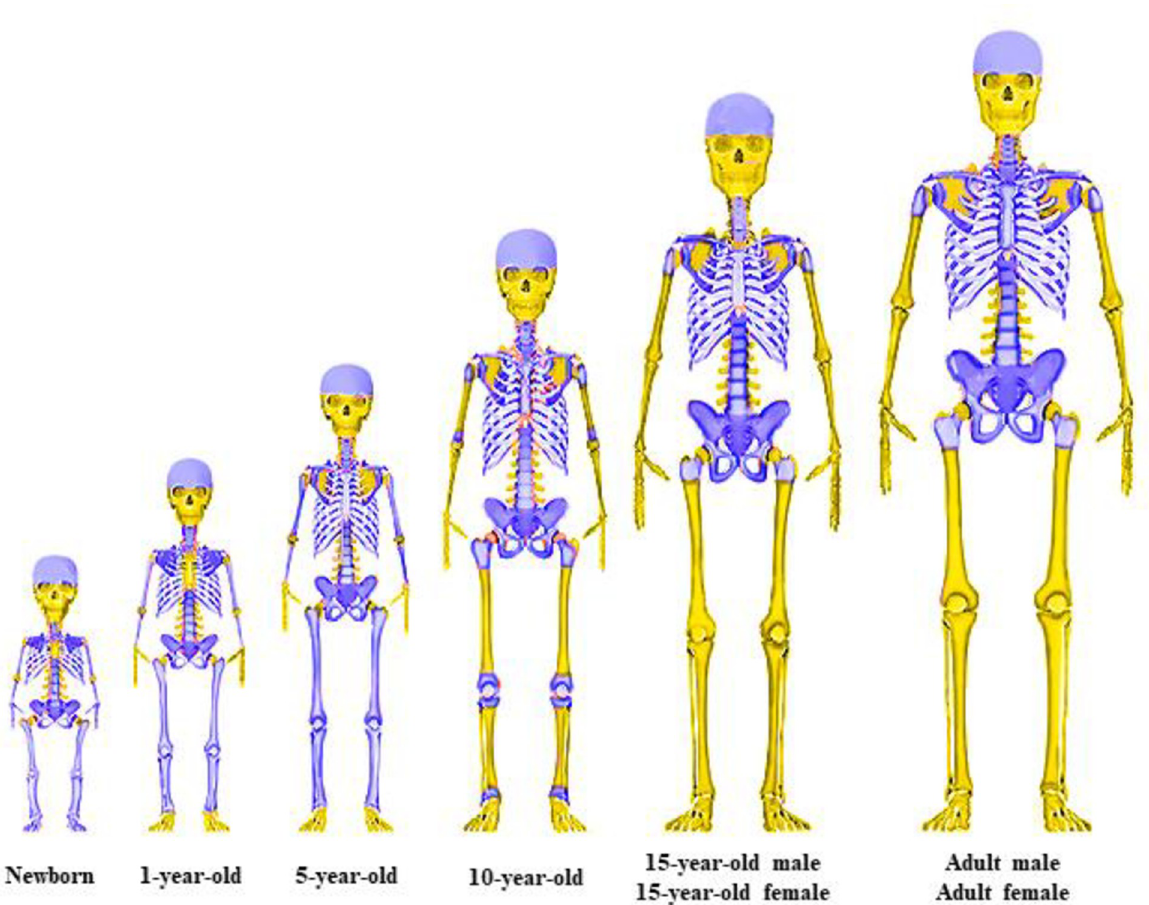
Fig 1. Location of hematopoietic bone sites (purple color) in humans of different ages. Other bones (yellow) do not contain active marrow and are not considered for modeling.